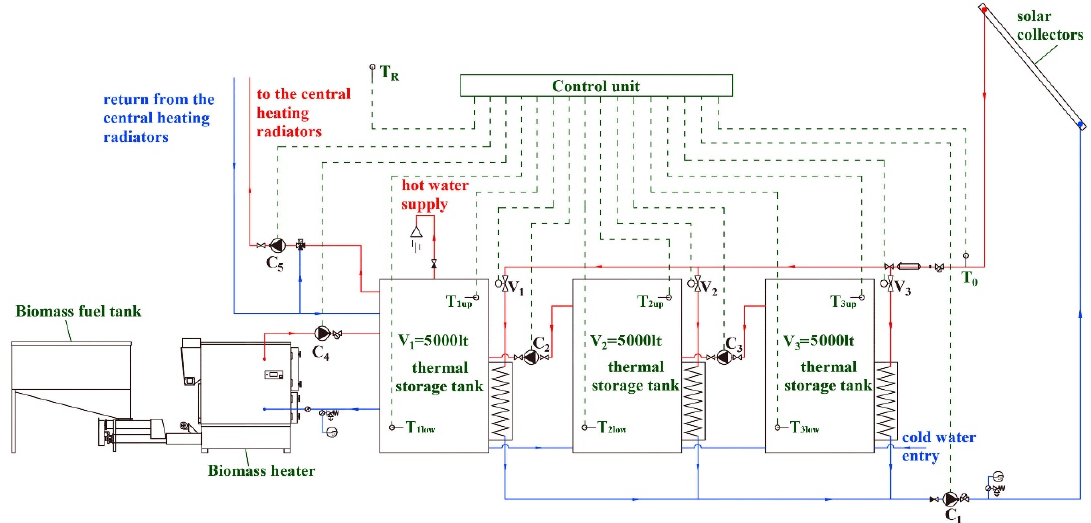
Figure 9. Graphical representation of the connectivity layout and the realization of the operation algorithm of the proposed system.